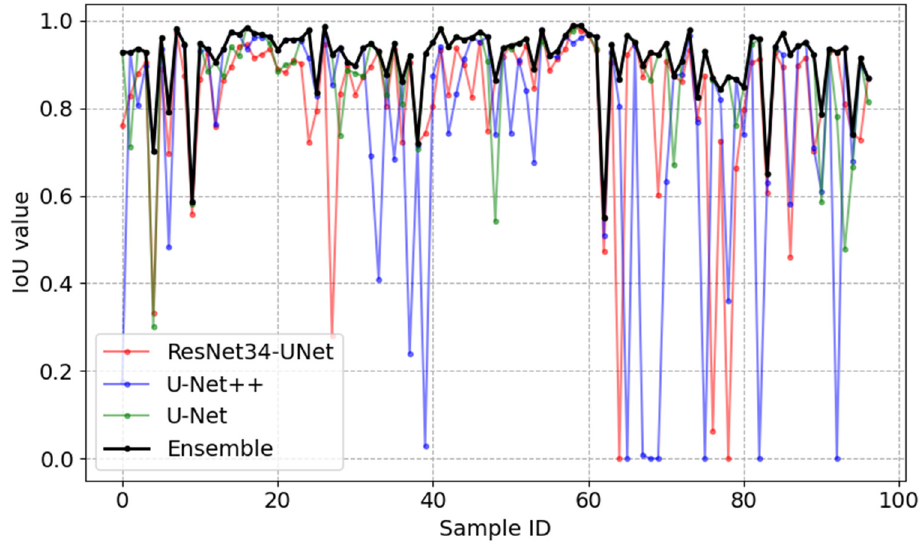
Figure 11. Relationship graph between the 𝐼𝑜𝑈 value, tested image ID and segmentation model.